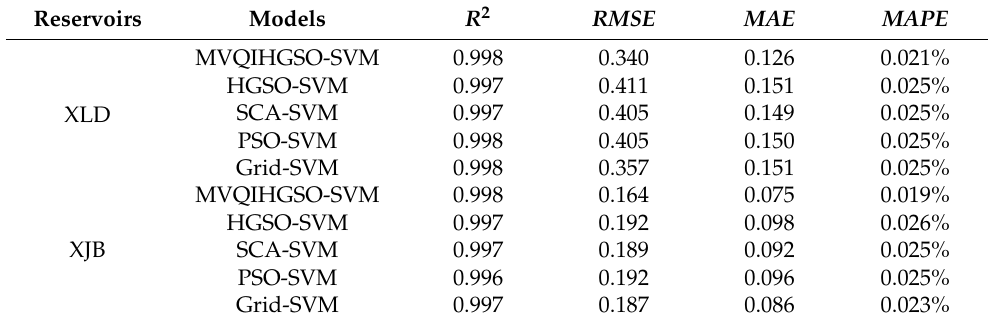
Table 8. Validation indices value of different operation rule derivation models on validation